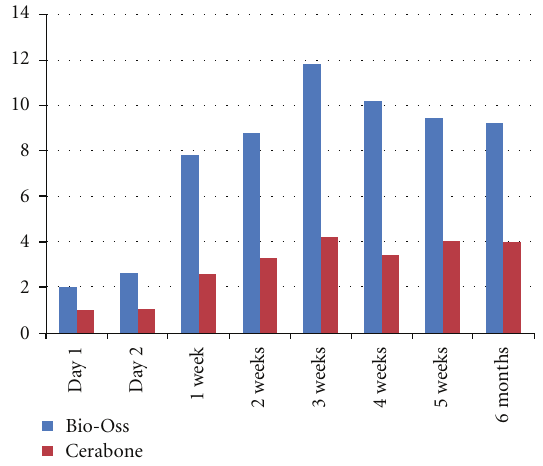
Figure 4: Calcium release (mg/g) at di ff erent time intervals. Release rate was almost constant after 2 months.